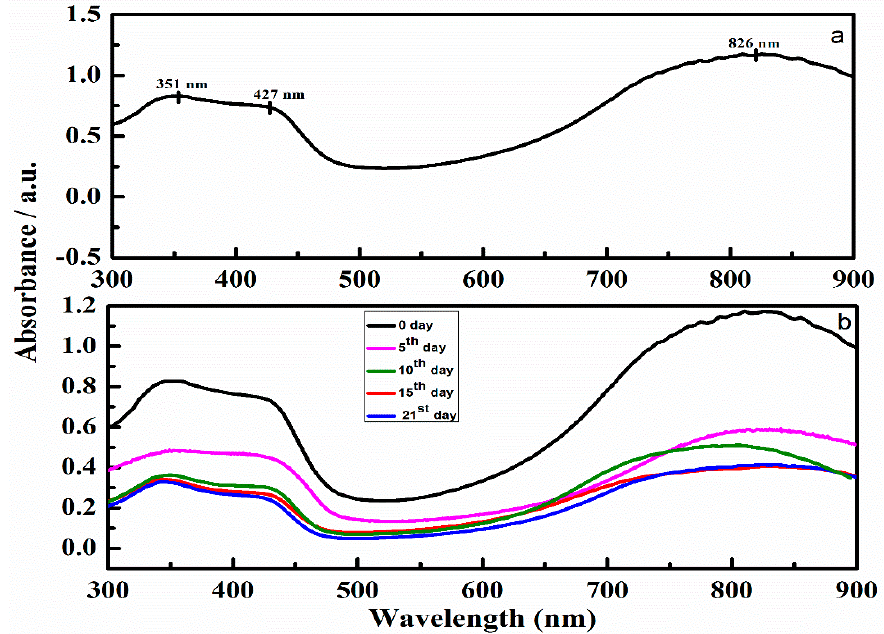
Figure 6. ( a ) UV-visible spectrum of patch-5 and ( b ) UV-visible spectra of patch-5 recorded at 0th, 5th, 10th, 15th and 21st day.